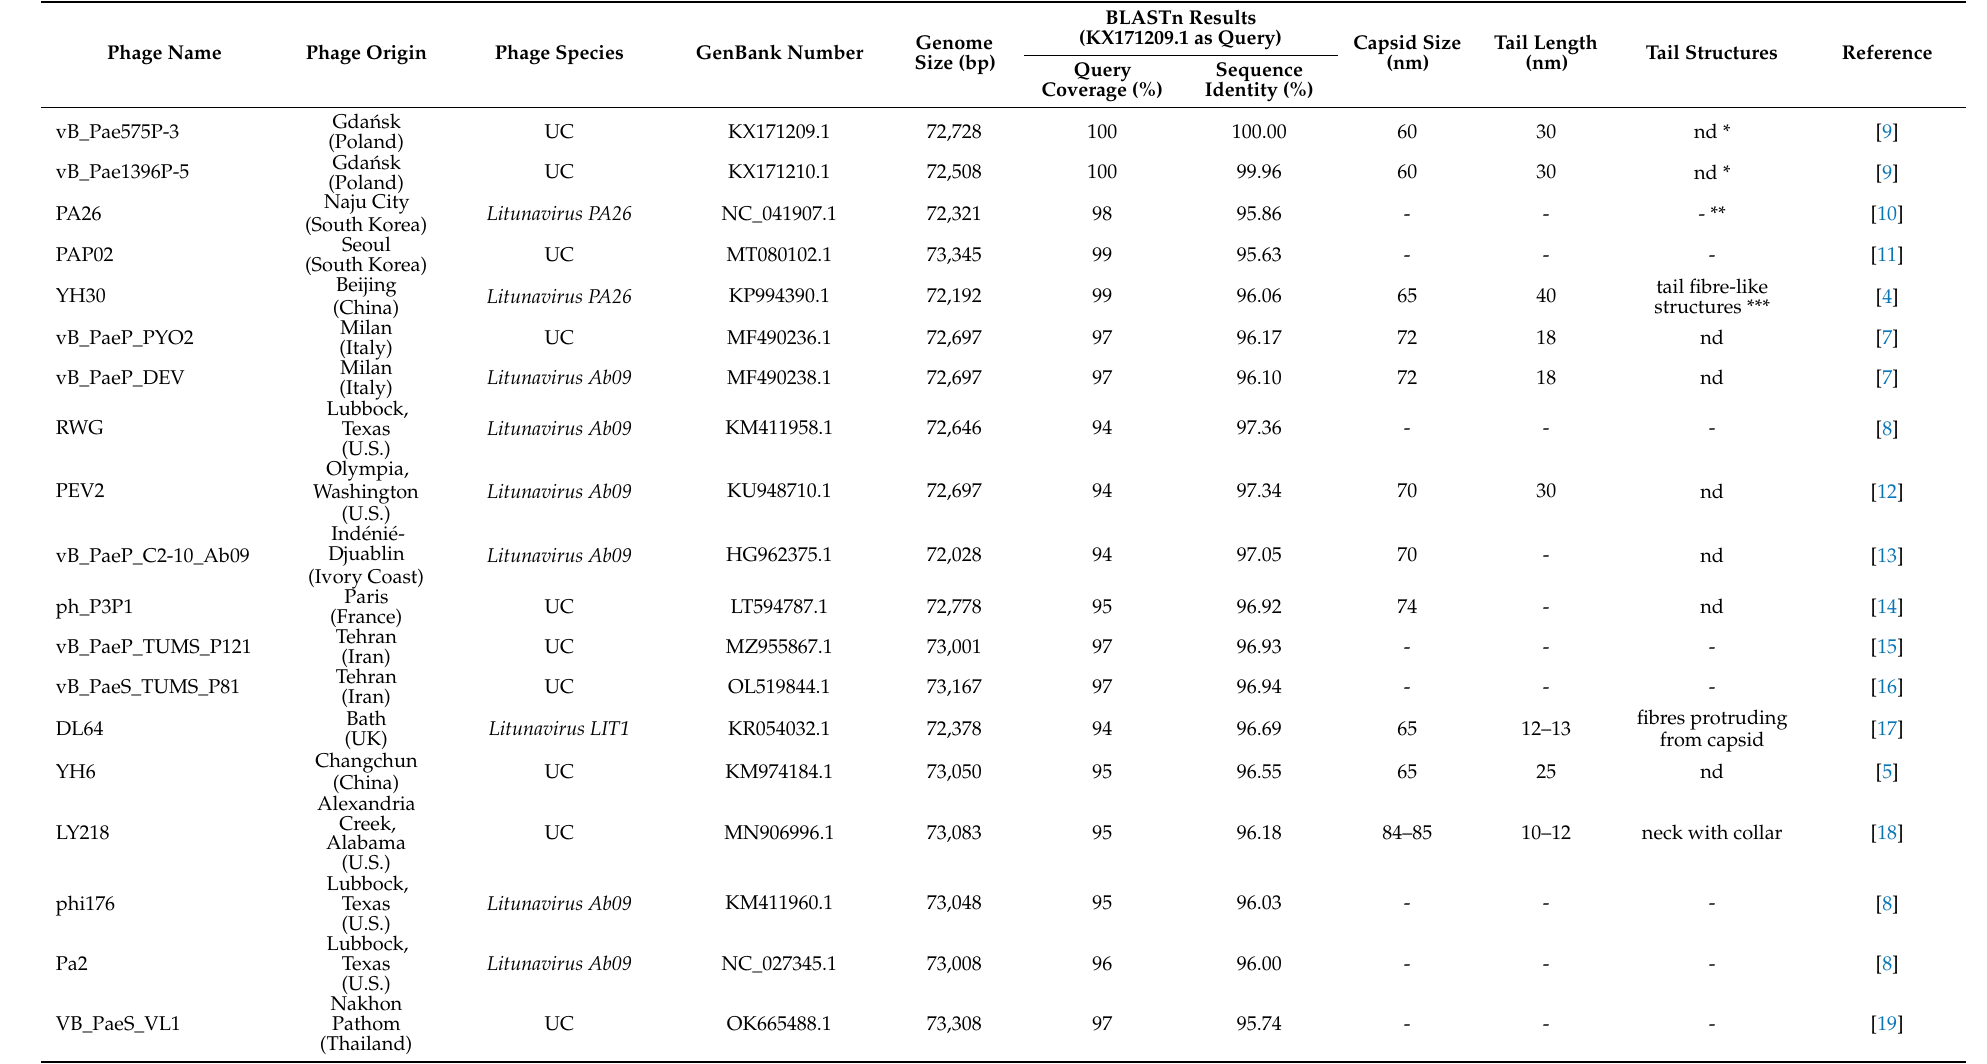
Table 1. The summary information of Litunavirus and Luzseptimavirus phages analysed in this